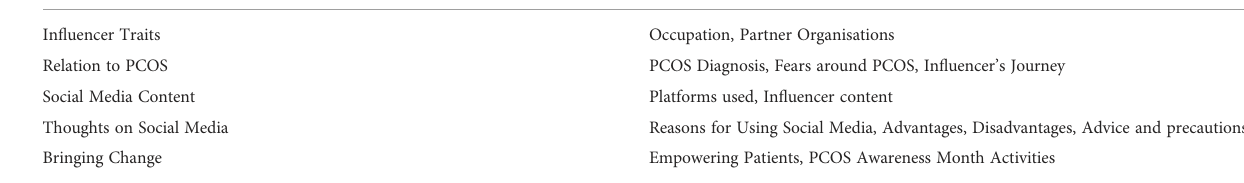
TABLE 3 Thematic analysis of the interviews of PCOS in fl uencers.